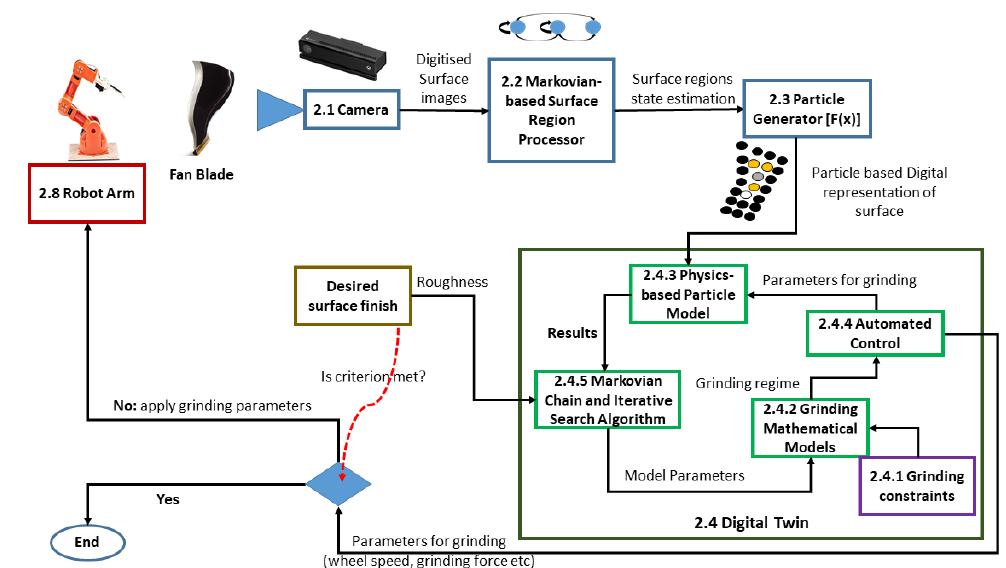
Figure 3. Showing our proposed automated architecture for MRO. The black dots above are used to depict the top polyurethane layer, the yellow or white dots the middle epoxy primer layer and the grey dots the innermost composite layer. The color scheme follows the format used in Figure 2. For example, purple depicts the grinding constraints for both human and the digital twin; Blue depicts an approach for digitizing a manual visual inspection. The desired surface finish module indicates the surface condition finish required. This indirectly provides the criterion for our architecture to decide whether to continue grinding or not. The numbers in the architecture’s module depict the section numbers in the manuscript.